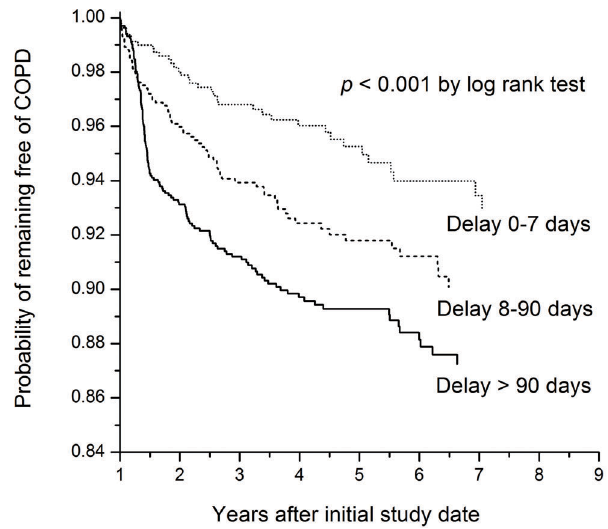
Figure 4. Curves of time to onset of chronic obstructive pulmonary disease (COPD) among TB patients with different delays in anti-tuberculous treatment.